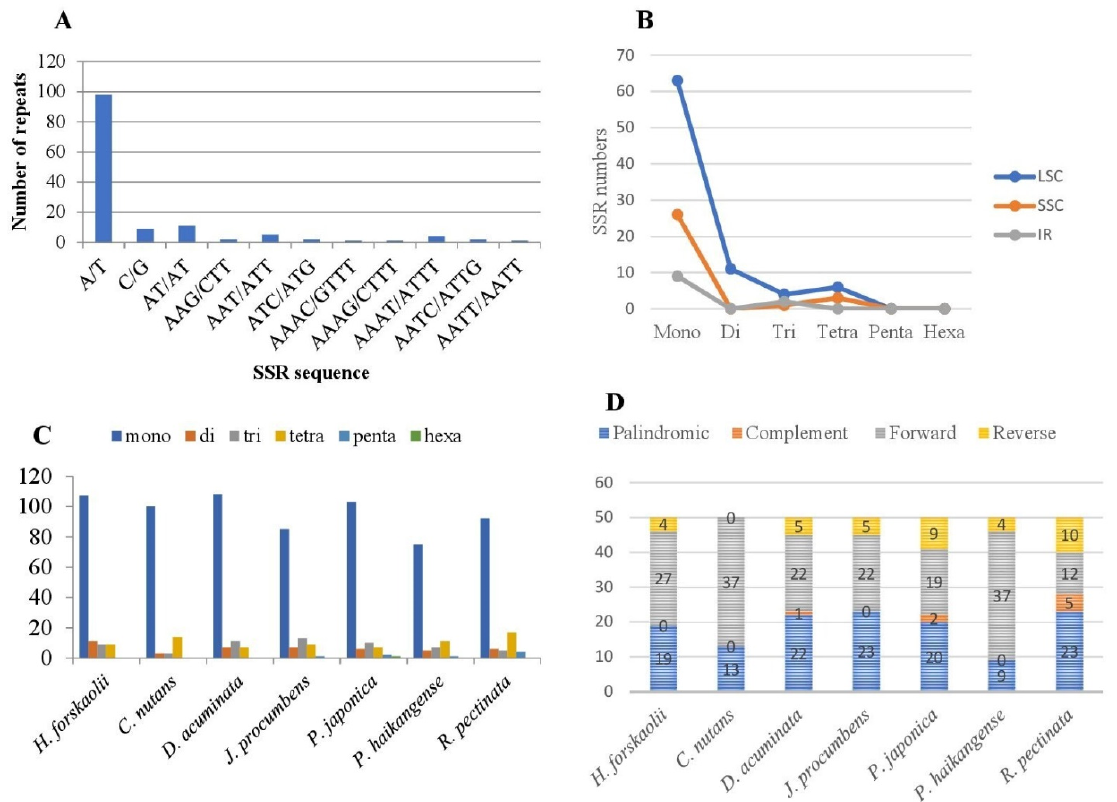
Figure 4. Repeat analyses of the sampled plastome of Justicae. ( A ): Frequency of different SSR motifs in different repeat types in H. forskaolii chloroplast genome. ( B ): Distribution of SSR in LSC, SSC, and IR regions. ( C ): Number of different SSR types in the chloroplast genome of seven Justiceae. ( D ): Number of different repeats in chloroplast genomes of seven species of Justiceae.